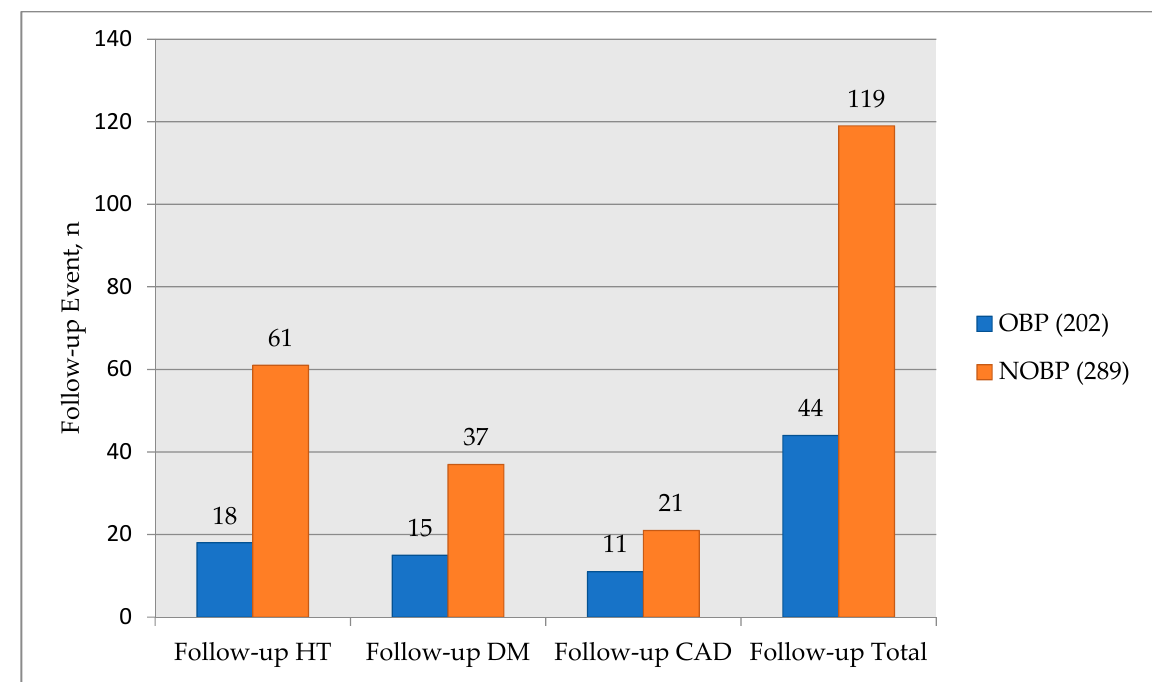
Figure 5. Comparison of events at 8-year follow-up. OBP, optimal blood pressure; NOBP, non-optimal blood pressure; n , number; HT, hypertension; DM, diabetes mellitus; CAD, coronary artery disease.